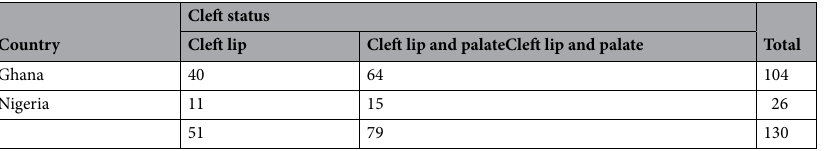
Table 2. Distribution of the case-parent trios based on the country of origin and cleft status. Majority (79) of the trio have CLP. Each trio consisted of a nsCL/P affected child and unaffected parents. SIFT and Polyphen2 SCORE Interpretation: Tolerated